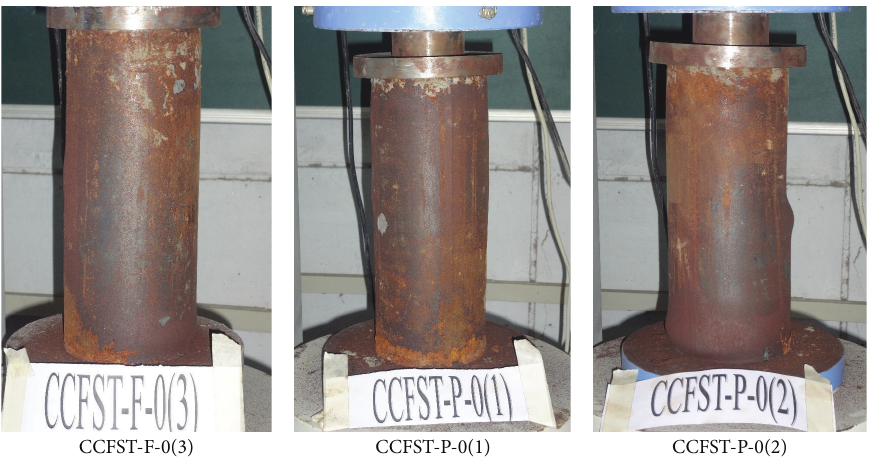
Figure 6: Failure pattern of circular CFST column subjected to full and partial compression.